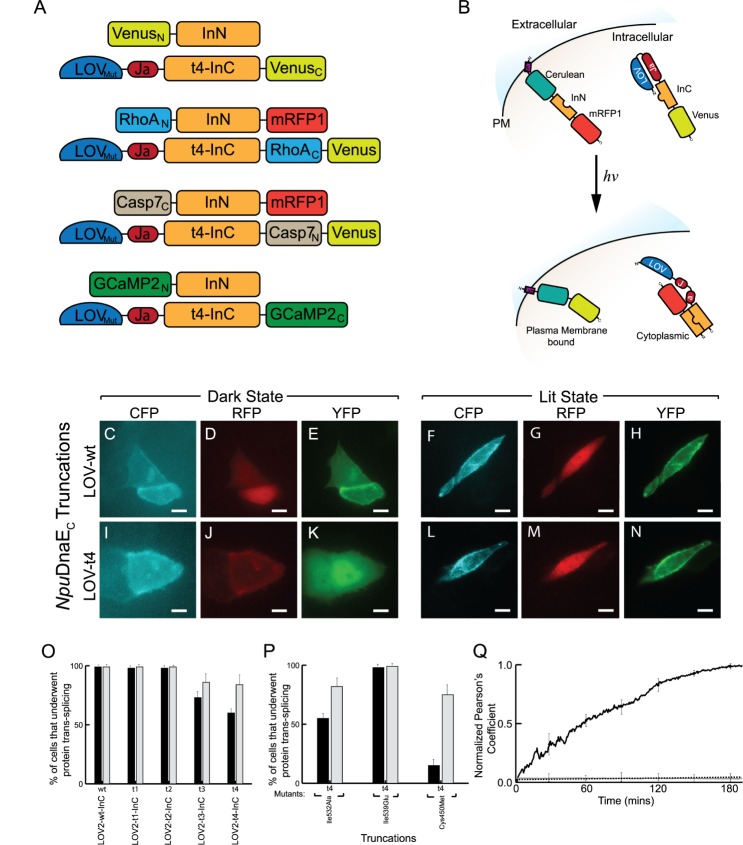
Photoactivatable NpuDnaE intein via LOV2 domain.(A) Layout of the different protein constructs used in this study. ‘N’ and ‘C’ denote amino and carboxyl fragments, respectively. (B) General schematic diagram of photoactivatable NpuDnaE intein before and after photostimulation with blue-light (Dark- and Lit-state, respectively). Blue-light photostimulation releases InC inhibition and allows protein trans-splicing to proceed. HeLa cells co-expressing M-Cerulean-InN-mRFP with LOV2-Jα fused to wild type (wt) InC (C-E) before and (F-H) after photostimulation. Similary, ‘t4’ truncated InC mutant co-expressed with M-Cerulean-InC-mRFP (I-K) before and (L-N) after photostimulation in HeLa cells shown in CFP, RFP, and YFP fluorescence, respectively. (O) The percentage of co-transfected cells with non-mutant LOV2 that has undergone PTS activity. (P) Percentage of co-transfected cells with mutant forms of LOV2 that has undergone PTS activity. (Q) Time course showing co-localization of CFP and YFP after blue-light photostimulation as measured by normalized Pearson’s coefficient (black trace), baseline without photostimulation (dotted line), and baseline with photostimulation of construct without LOV (grey trace). ‘N’ and ‘C’ denote amino and carboxyl fragments, respectively. Black and grey bars refer to dark- and lit- states, respectively. Error bars represent standard deviation, n > 6 experiments with over 20 cells observed.